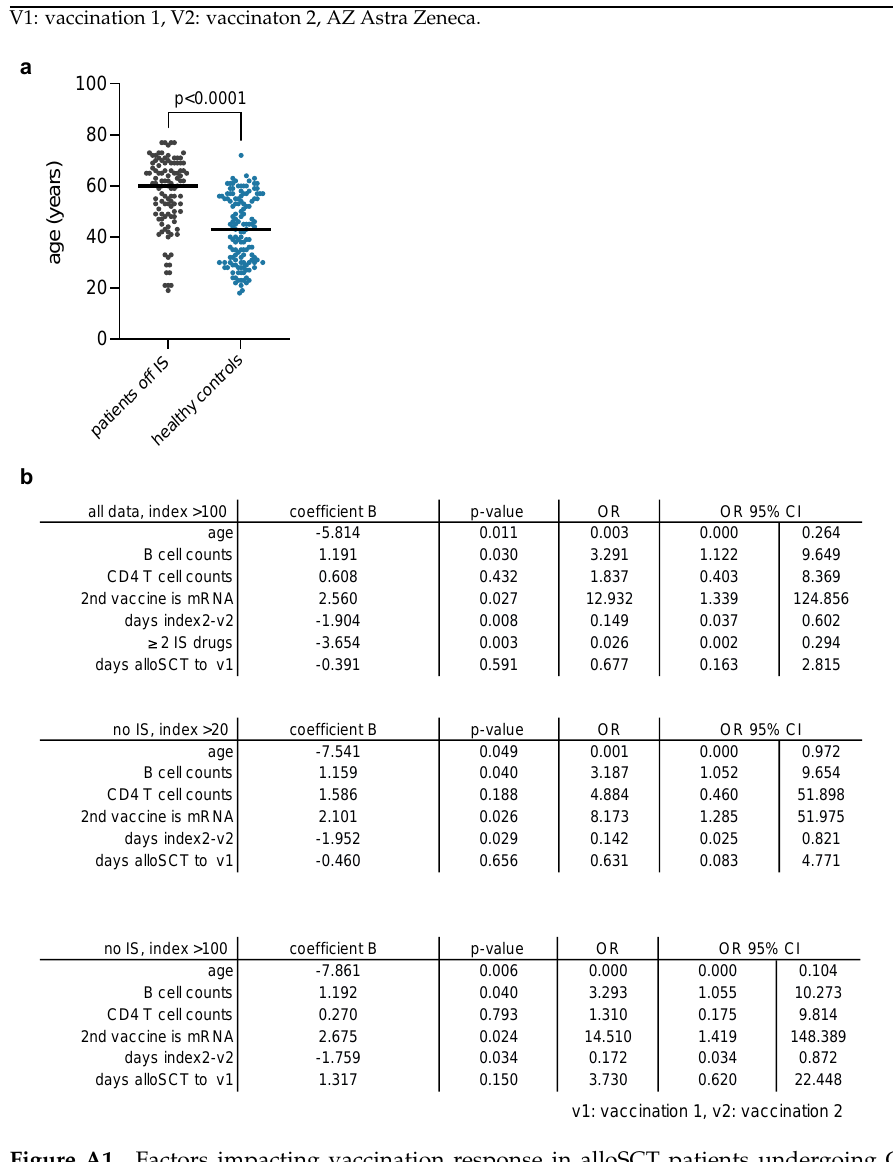
Appendix Figure A1. Factors impacting vaccination response in alloSCT patients undergoing COVID-19 vaccination. ( a ) Age (years) of patients off IS versus healthy controls. Lines indicate medians. Mann Whitney U test; (b) Logistic regression identifies independent factors associated with 263 humoral responses post COVID-19 vaccination in the total cohort (index >100, top), and in the sub- 264 group of patients off IS (n=107, index >20, middle, index>100, bottom). v1: first vaccination, v2: sec- ond vaccination, continuous variables were log10-transformed, OR odds ratio.